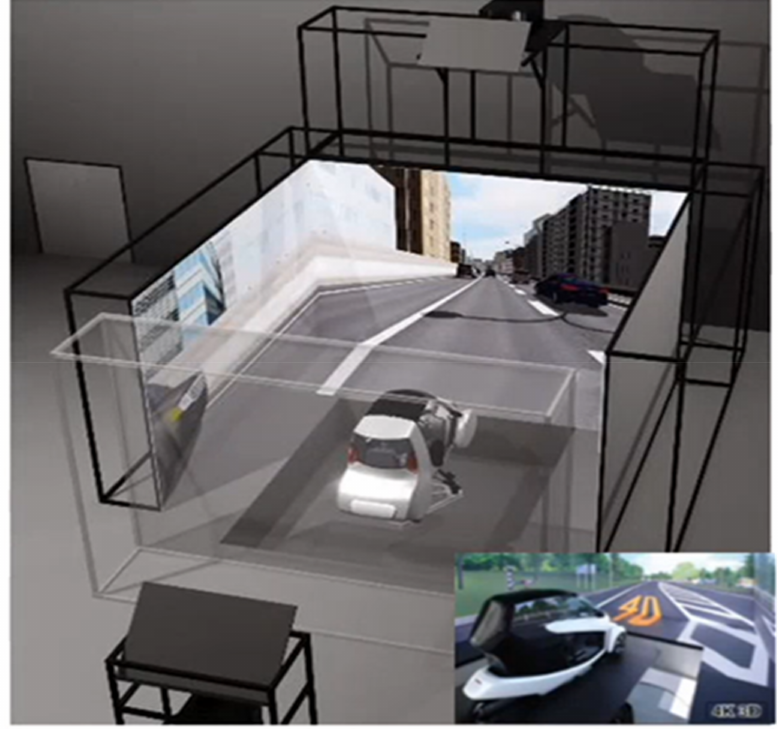
Figure 1. The Immersive Driving